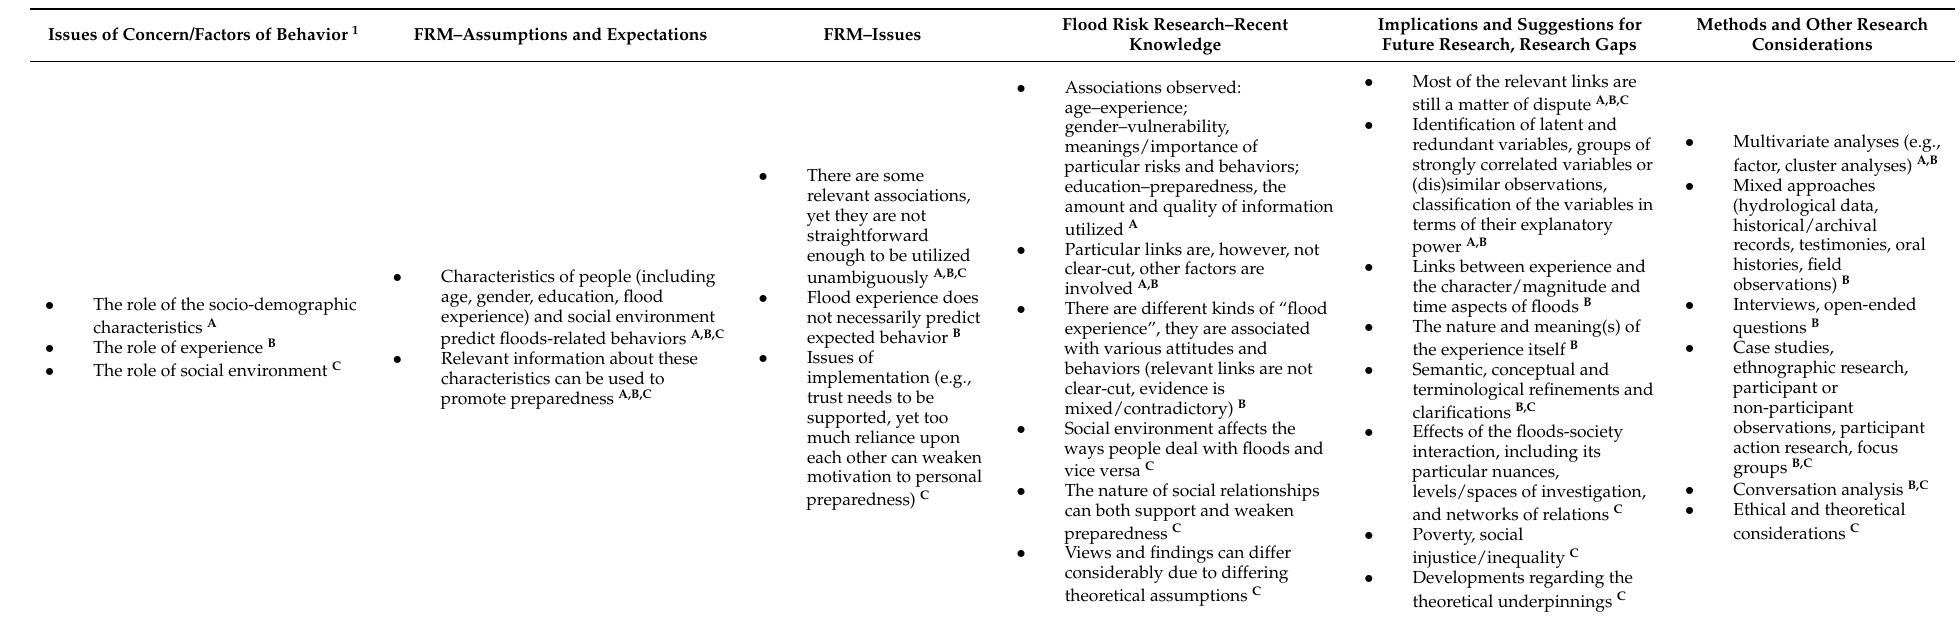
Table 5. People and floods–overview of findings, implications, and suggestions for future flood risk research